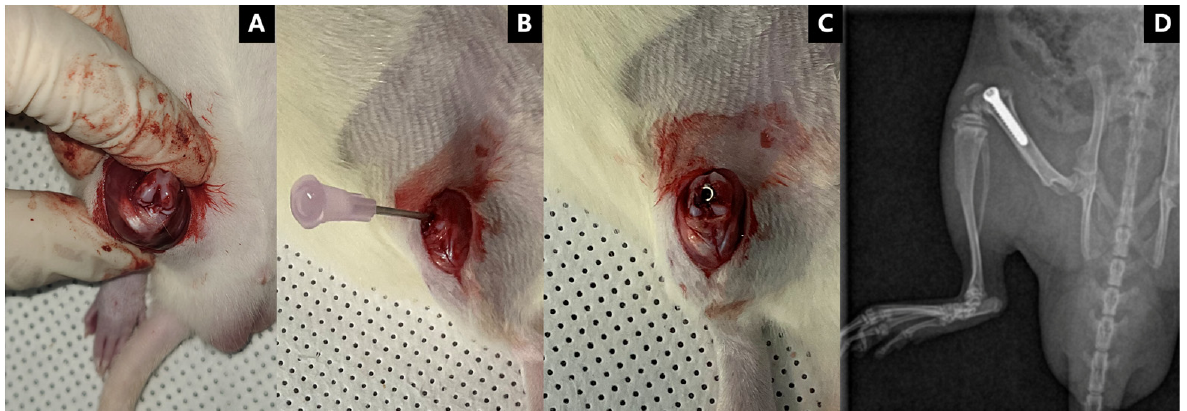
Figure 1. Rodent PJI model for testing antimicrobial efficacy of MLTRPB coating. ( A ) femoral condyle is exposed after approach to the knee joint, ( B ) intramedullary identification is made with 18 g needle, ( C ) insertion of the coated screw, and ( D ) postoperative x-ray showing adequacy of implant insertion.